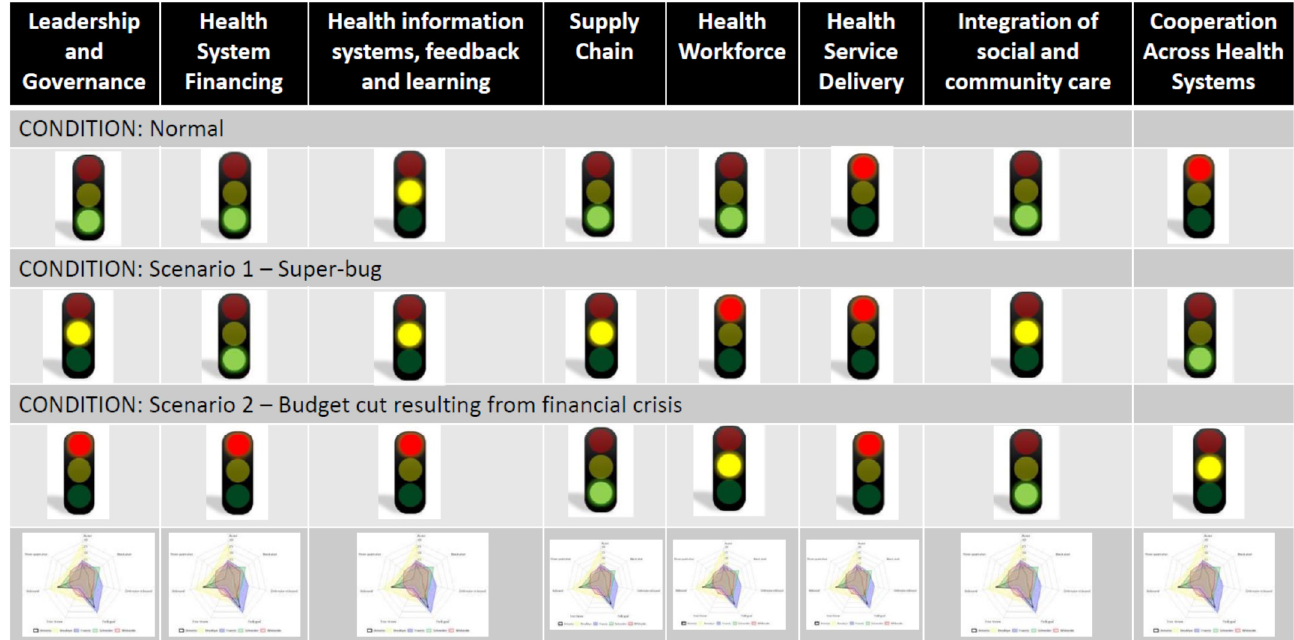
Figure 4. A sample scorecard to illustrate an overview of resilience test findings. The radar plots in the figure are for illustrative purposes only. Source: Expert Panel Opinion [10].